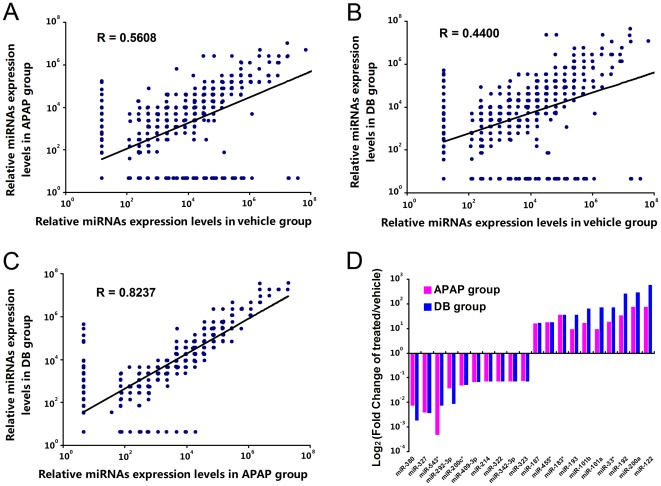
Analysis of serum miRNA expression profiles explored by TLDA.(A) Correlation and scatter plot analysis of relative miRNAs expression levels in APAP group and vehicle group; (B) Correlation and scatter plot analysis of relative miRNAs expression levels in DB group and vehicle group; (C) Correlation and scatter plot analysis of relative miRNAs expression levels in DB group and APAP group; In Panel A, B and C, the relative expression levels of each miRNA to an internal control was calculated by using the equation 2−ΔCT×107, in which ΔCT = CT miRNA−CT U6. The CT value of “Undetectable” was calculated as 40. (D) Top 10 upregulated and downregulated serum miRNAs detected by TaqMan low-density qPCR array. Fold change of treated/vehicle was calculated by using the equation 2−ΔΔCT, in which ΔΔCT = (CT miRNA−CT U6) DILI group−(CT miRNA−CT U6) vehicle group. And serum miRNAs were ranked by the fold change of the group with the largest upregulated fold (n = 10 per group, pooling).